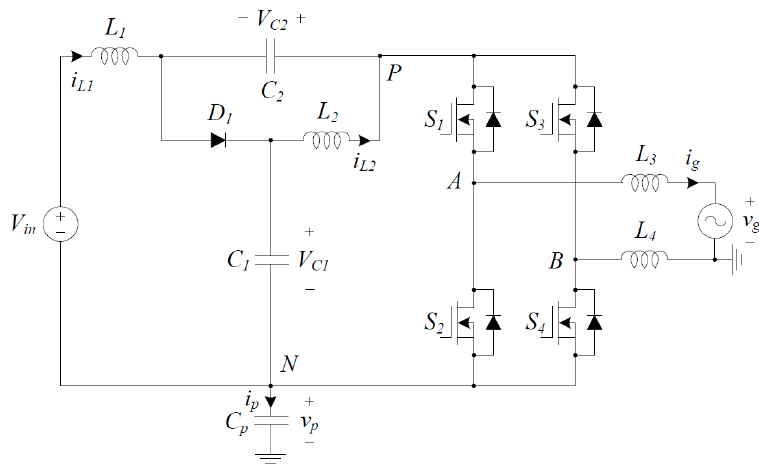
Figure 1. Circuit diagram of the QZS inverter for single-phase grid-tied applications.